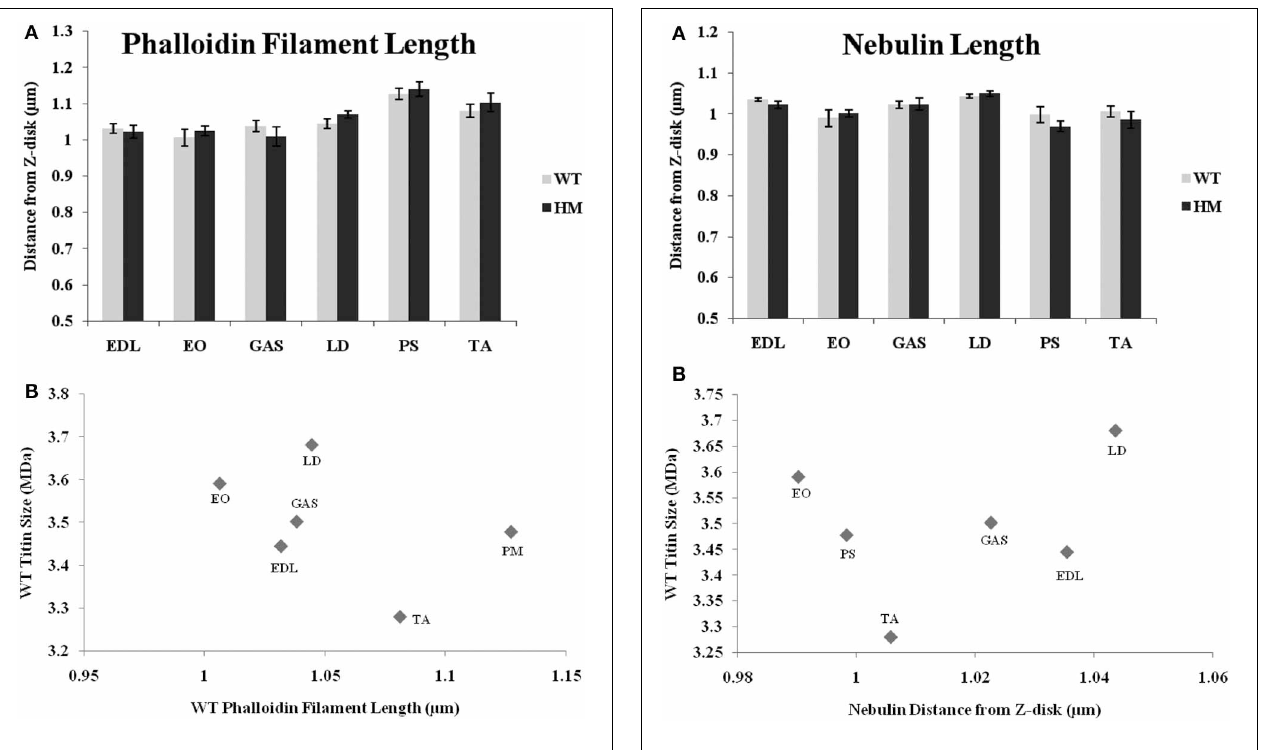
FIGURE 4 | (A) Nebulin N terminus determination of tin filament lengths in different muscles and rat genotypes. See Figure 3 for muscle and genotype abbreviations. (B) Relationship between titin size and nebulin estimated thin filament